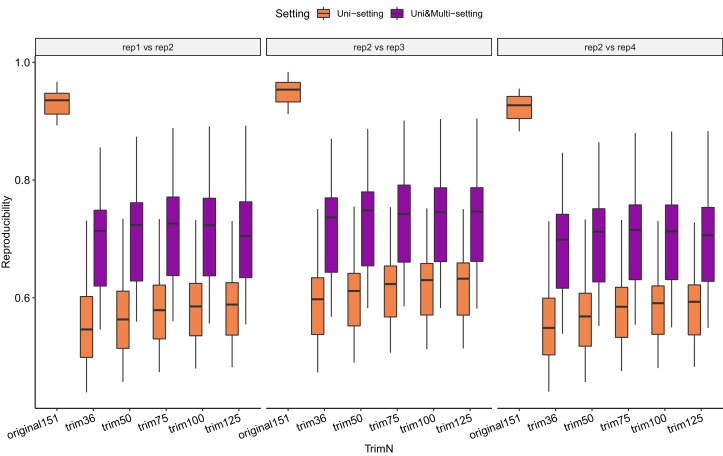
Reproducibility comparison between original Uni-setting and trimmed Uni-setting and Uni&Multi-setting across replicates at 40 kb resolution.